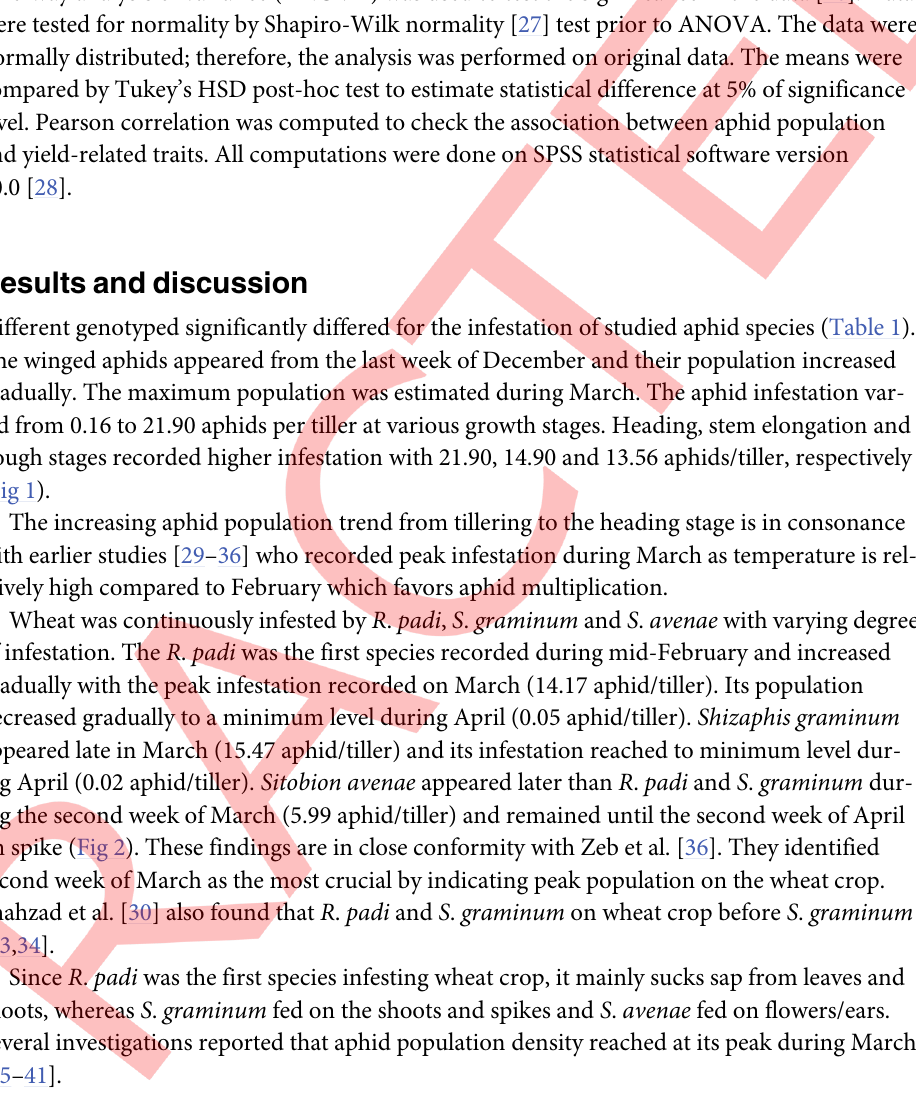
Table 1. Incidence of aphid species on different wheat genotypes used in the current study (n = 150).